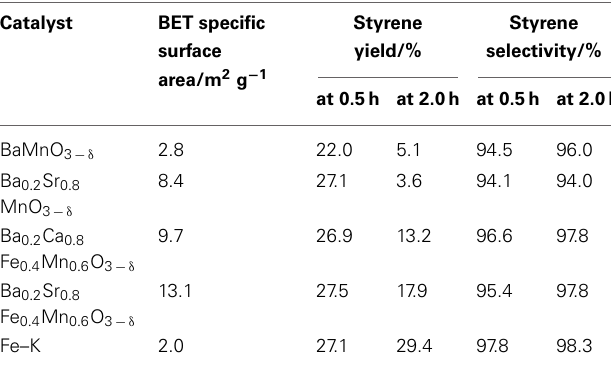
Table 3 | Catalytic performances for EBDH over perovskite catalysts: reaction times.